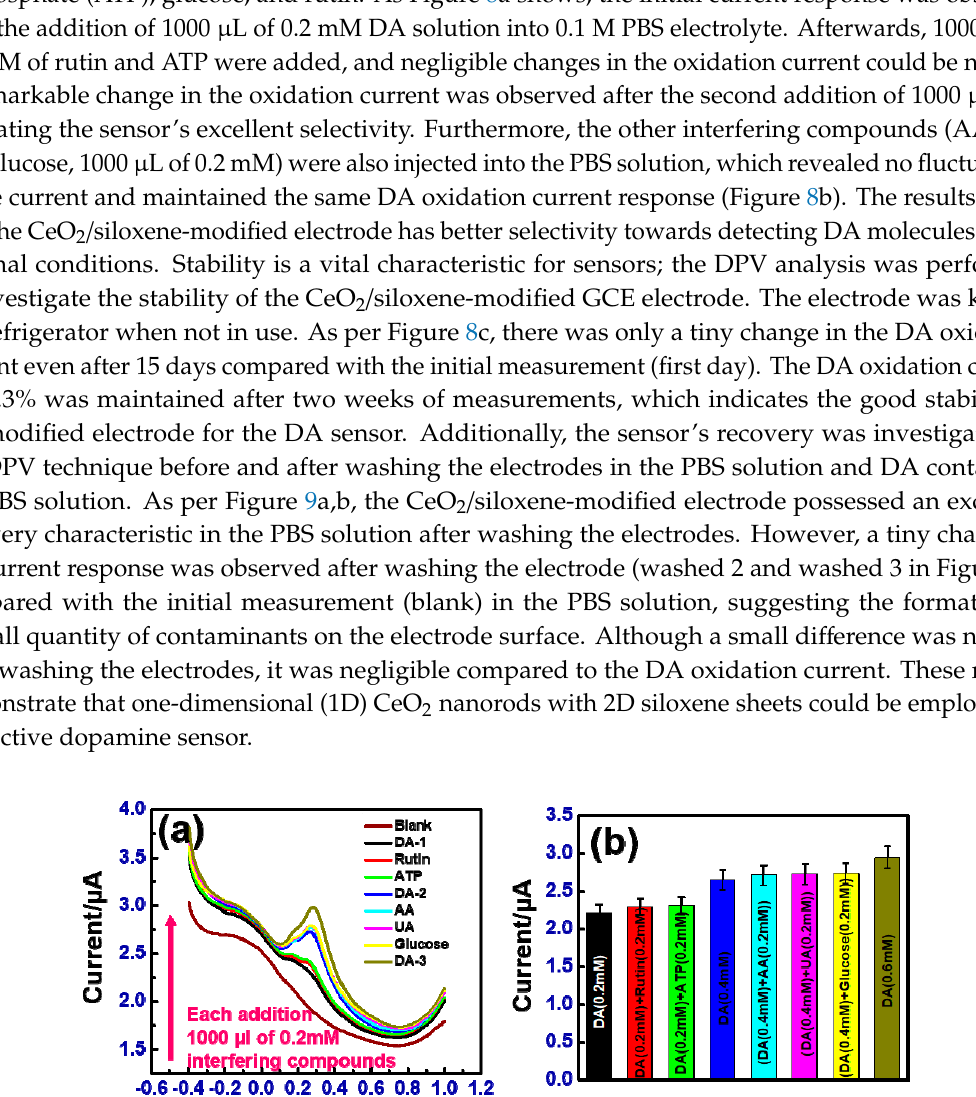
Figure 9. (a) The recovery test of the biosensors; (b) Current changes response of the test. 4. Conclusions In this work, we successfully combined Ce-MOF with siloxene and g-C 3 N 4 and prepared CeO 2 /siloxene and CeO 2 /g-C 3 N 4 composites using the pyrolysis method. The as-prepared samples were characterized by different tools and optimized the pyrolysis condition for better crystallization of